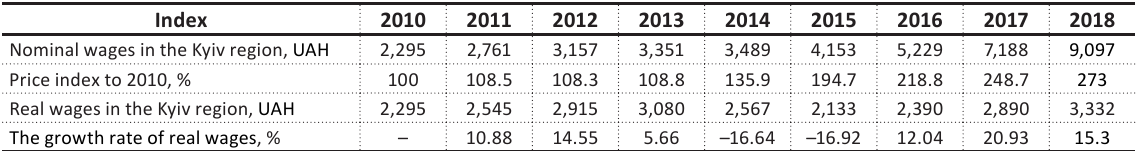
Table 2. The nominal and real wages dynamics in the Kyiv region in 2010–2018 Source: Prepared by the authors according to the data of